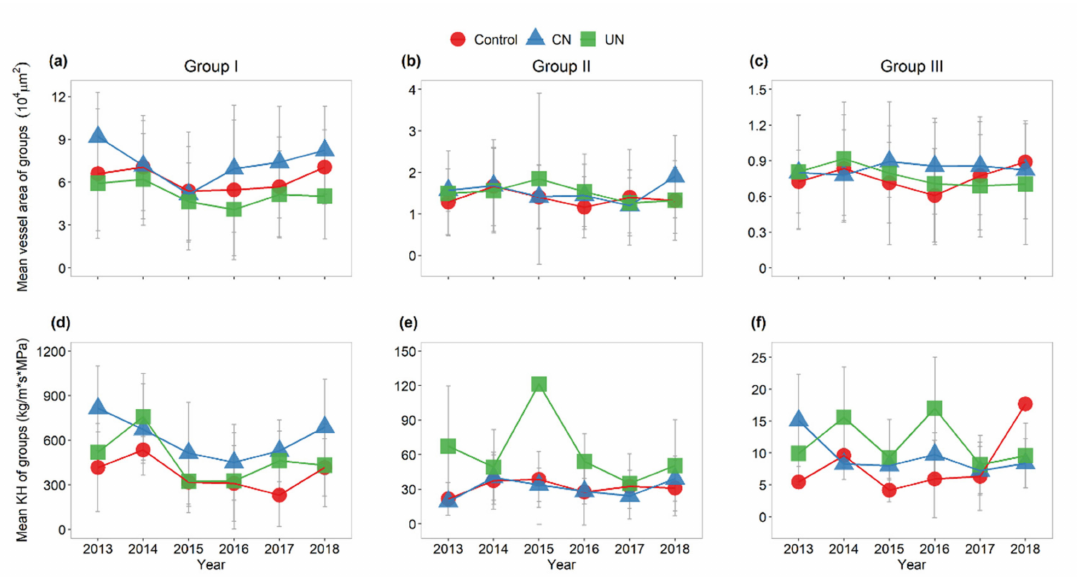
Figure 3. Mean vessel area and mean KH of groups I ( a , d ), II ( b , e ) and III ( c , f ) of Quercus variabilis under Control, canopy N addition (CN) and understory N addition (UN) treatments during 2013–2018. Error bars indicate standard deviation.